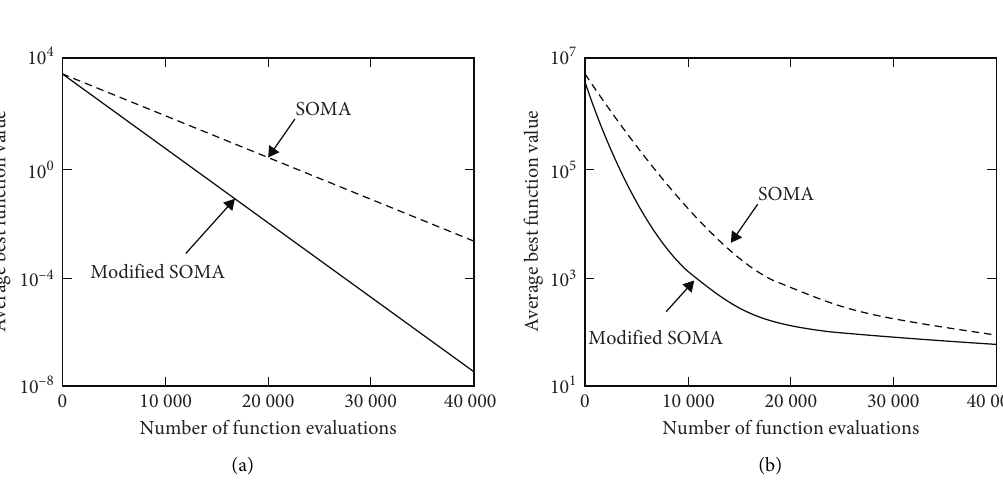
Figure 1: Convergence curves of modified SOMA and SOMA on the problem of full coincidence of global optimal values